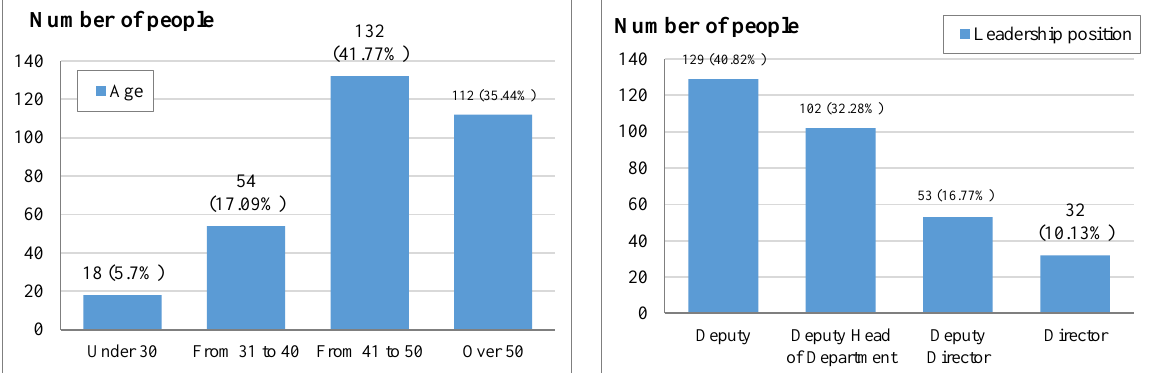
Figure 2. Descriptive statistics of the sample by sex and education level.